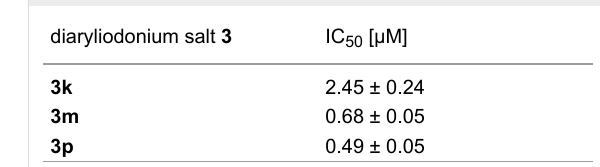
Table 1: Cytotoxicity of diaryliodonium salts 3k , 3m and 3p against a human histiocytic lymphoma cell line (U937).